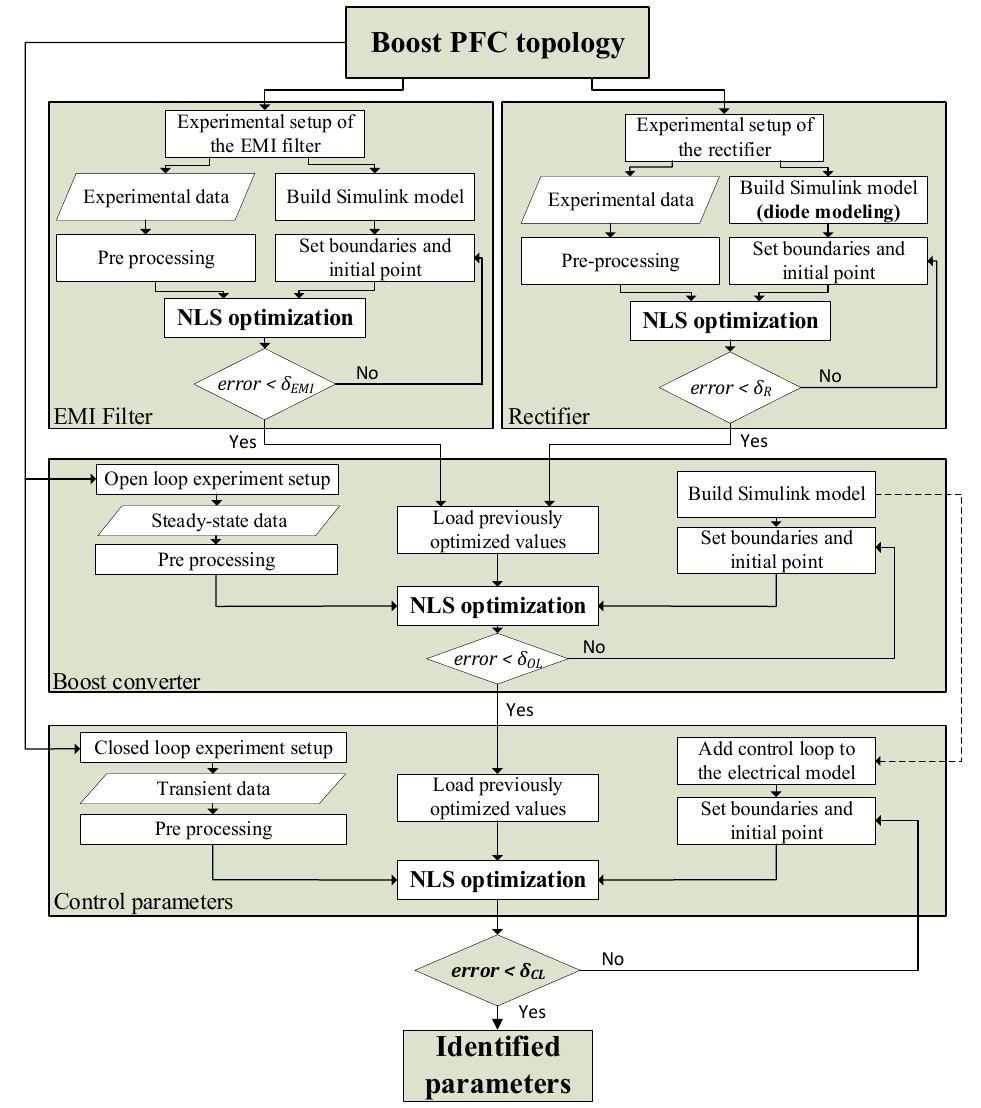
Figure 5. Proposed methodology to identify the parameters of the boost PFC converter.